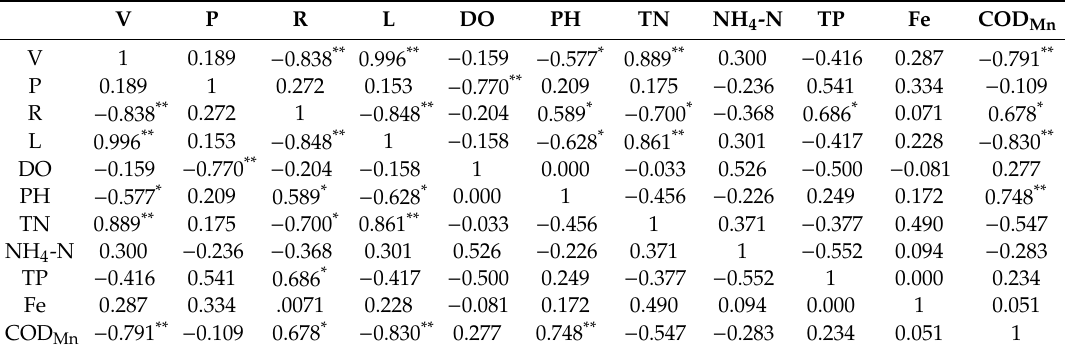
Table 1. Correlation analysis of hydrology and water quality elements.